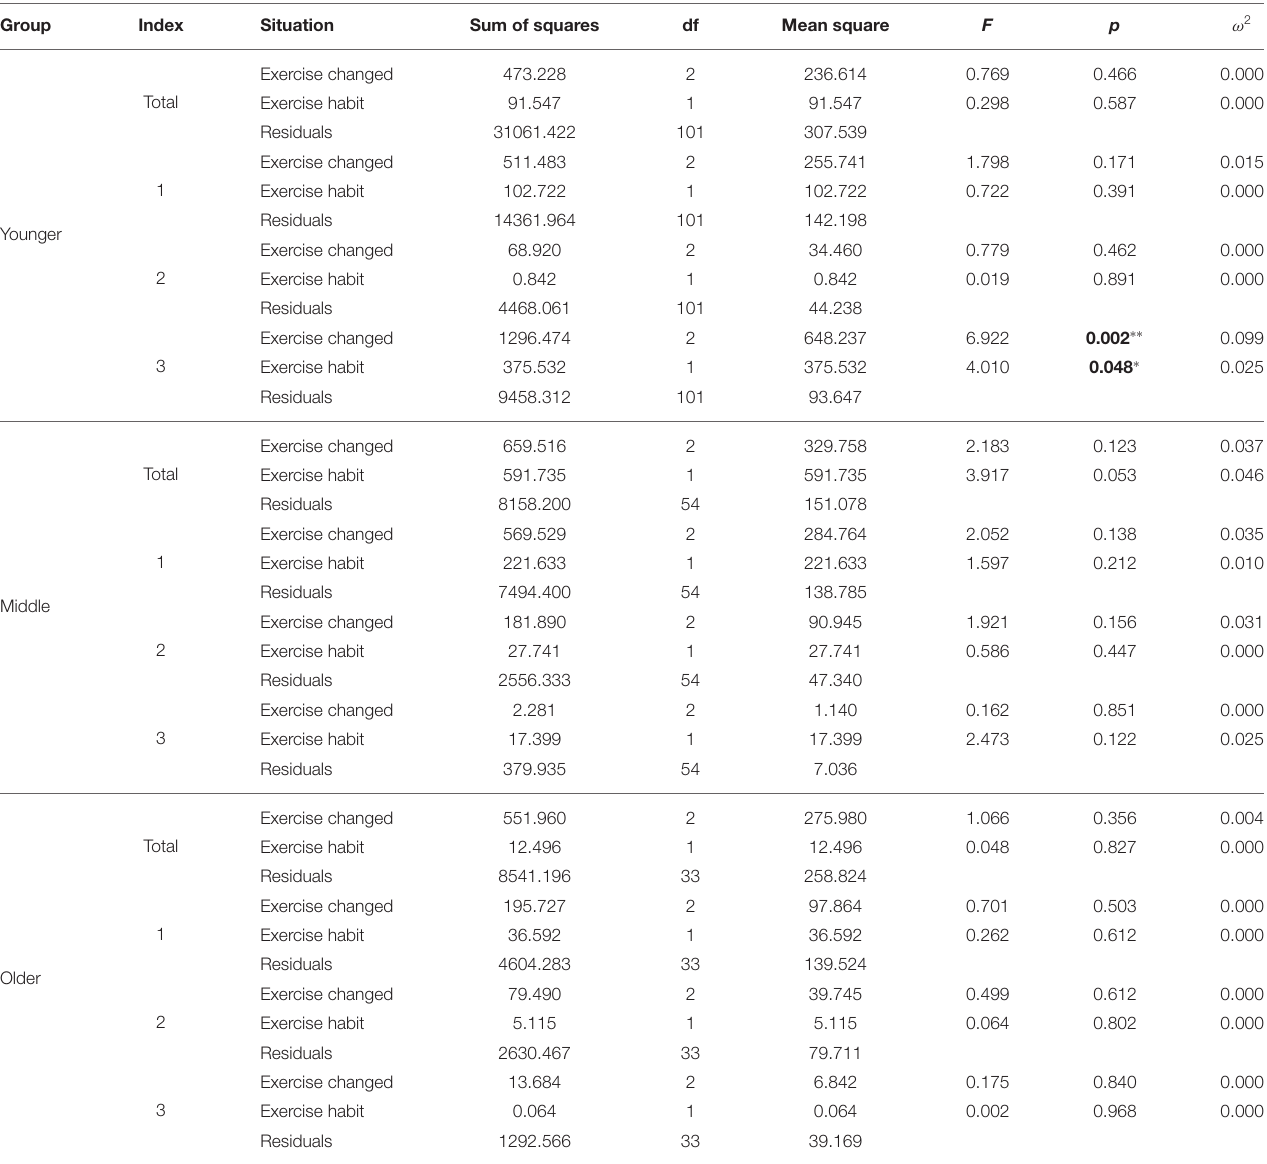
TABLE 2 | ANCOVA results of squat scores, exercise changed, and exercise habit of three groups.